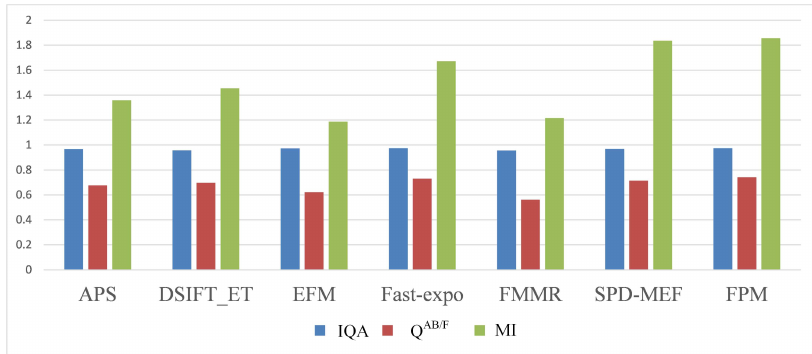
Figure 8. Mean value histogram of objective evaluation indicators obtained by the seven fusion methods. Table 1. Mean value of the objective evaluation indicators obtained by the seven fusion